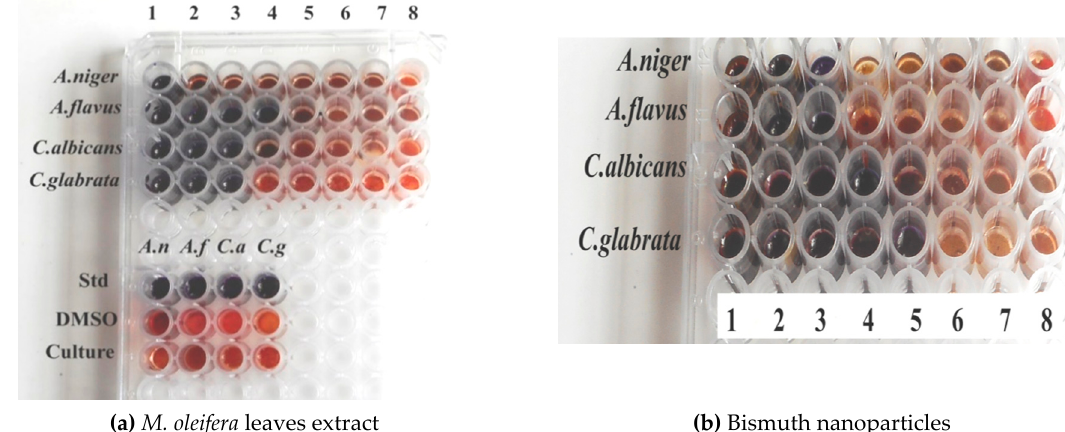
Figure 10. Resazurin microtiter assay plates for the antifungal activity of M. oleifera leaves extract and the synthesized bismuth nanoparticles. ( a ) M. oleifera leaves extract, ( b ) Bismuth nanoparticles.